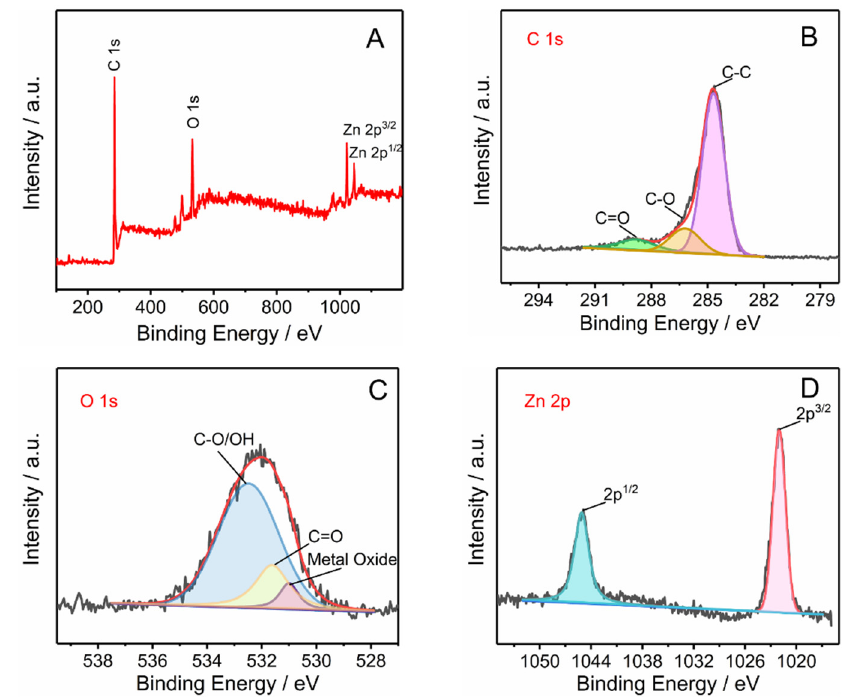
Figure 3. XPS survey spectrum of ( A ) ZnO/BC nanohybrid, core level spectra of ( B ) C 1 s, ( C ) O1 s, ( D ) Zn 2p.